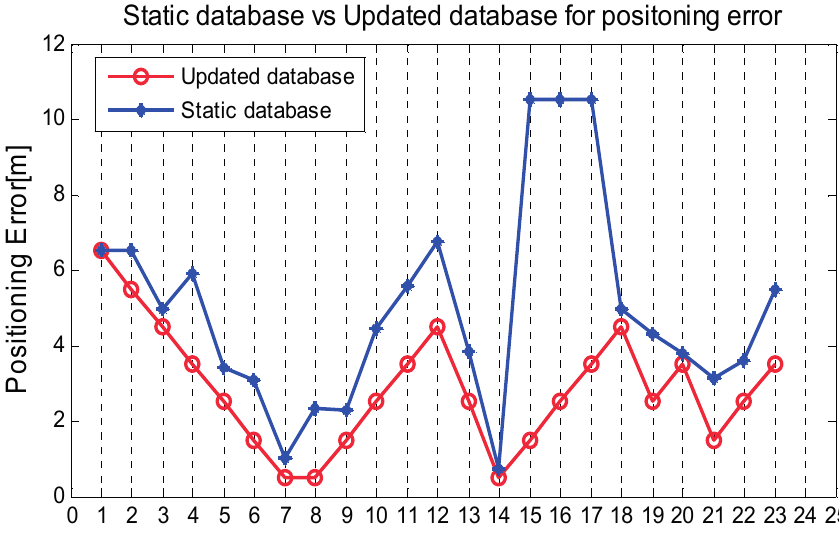
Figure 9. Comparison between the static database and updated database for positioning error with door closed.